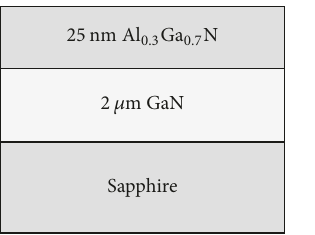
Figure 1: Schematic of AlGaN/GaN heterostructure.